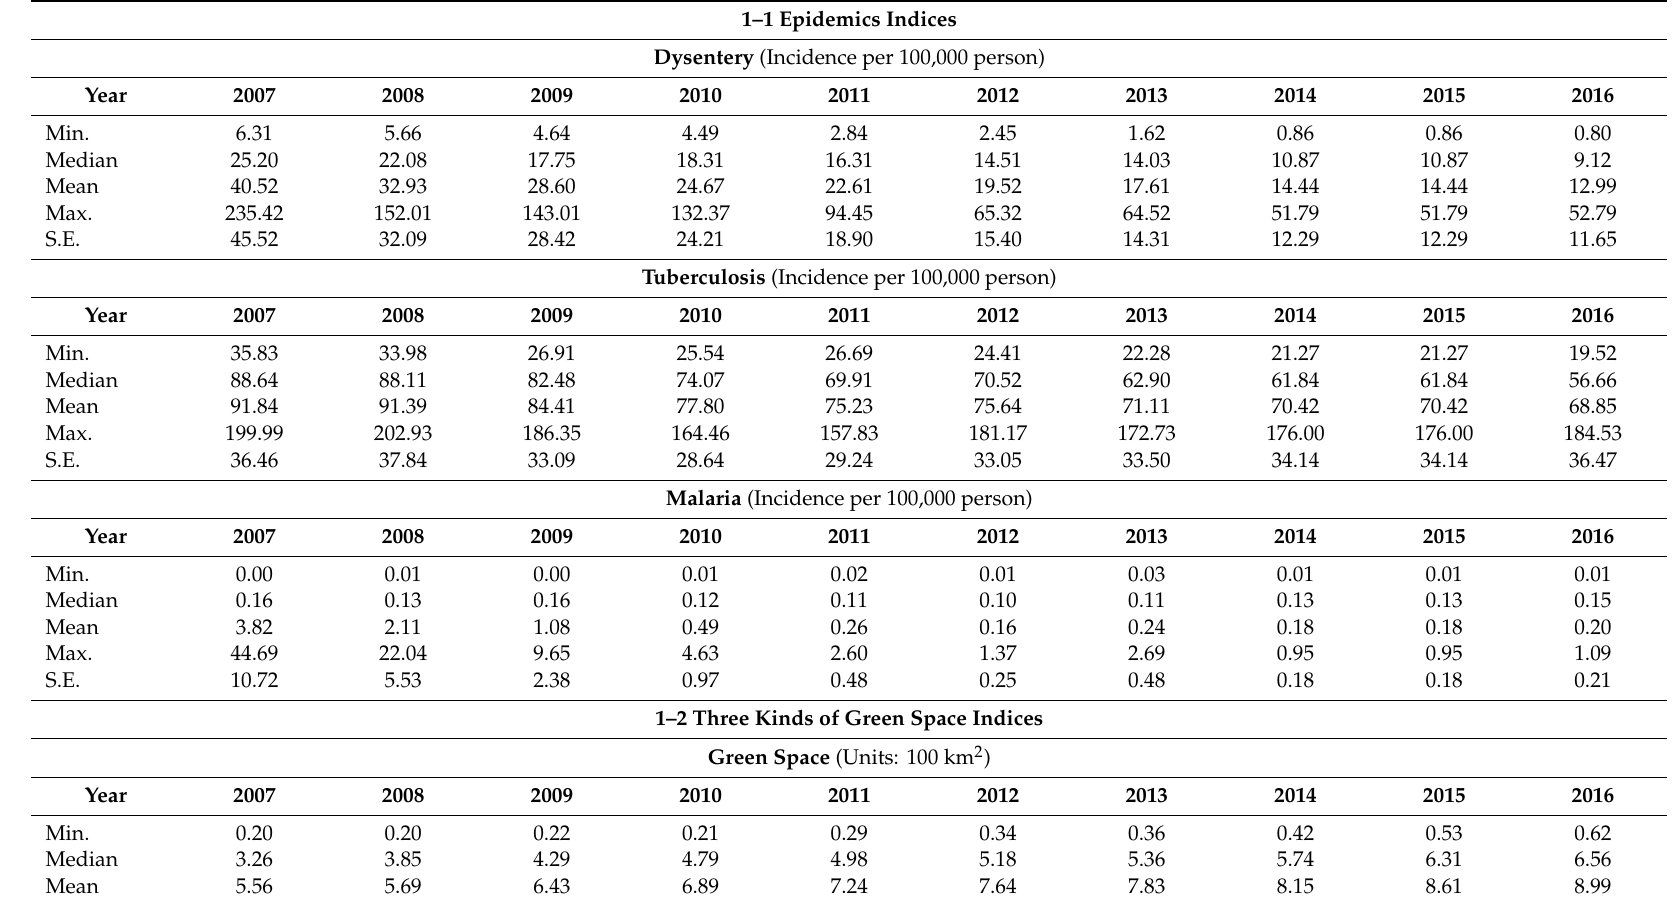
Table 1. Descriptive statistics of variables. GDP = gross domestic